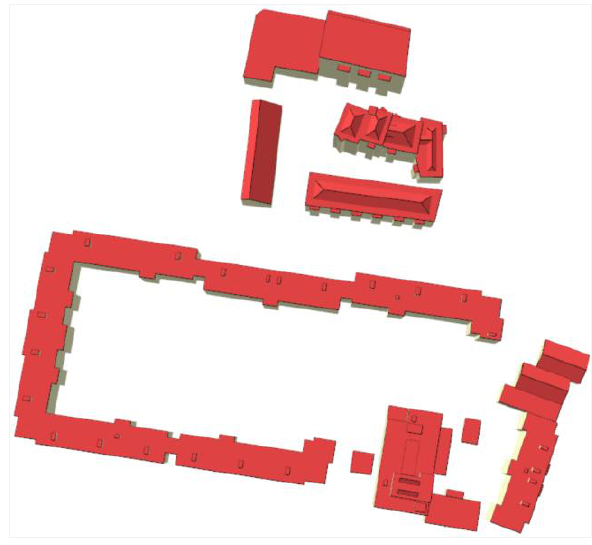
Figure 4. The plane segments and 3D models from